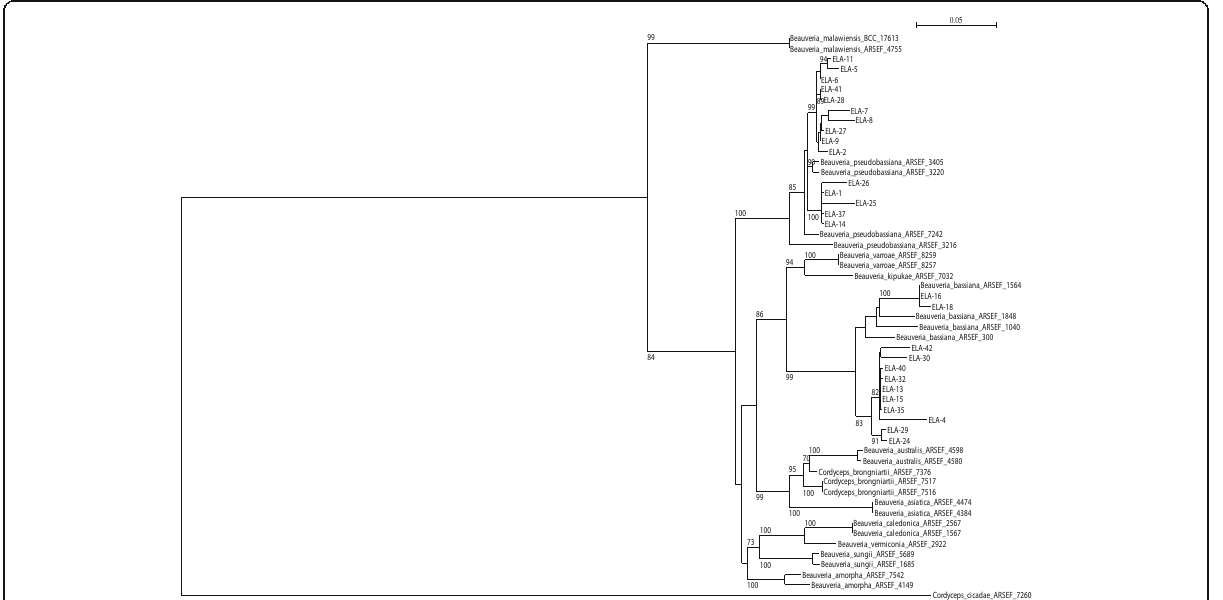
Fig. 1 Phylogenetic tree derived from maximum likelihood (ML) analysis of bloc gene sequences belonging to the Beauveria isolates and their closely related species indicated in the study of Rehner et al. (2011). Bootstrap values based on 1000 replicates were indicated above nodes. Bootstrap values C ≥ 70 are labeled. The scale on the top of the phylogram indicates the degree of dissimilarity